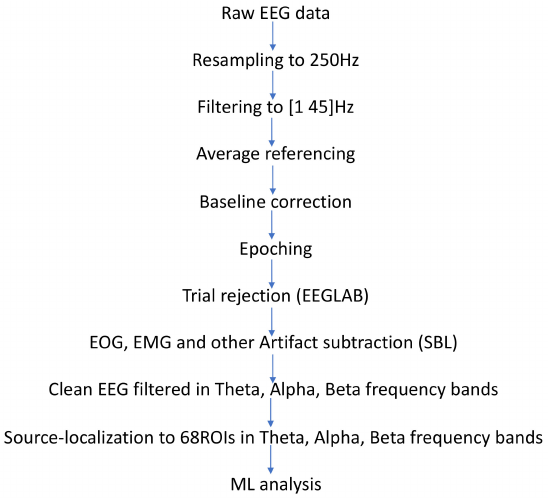
Figure A1. The EEG processing pipeline followed in Balasubramani et al., (2021). The source-localized data from that study were used for our present analysis.